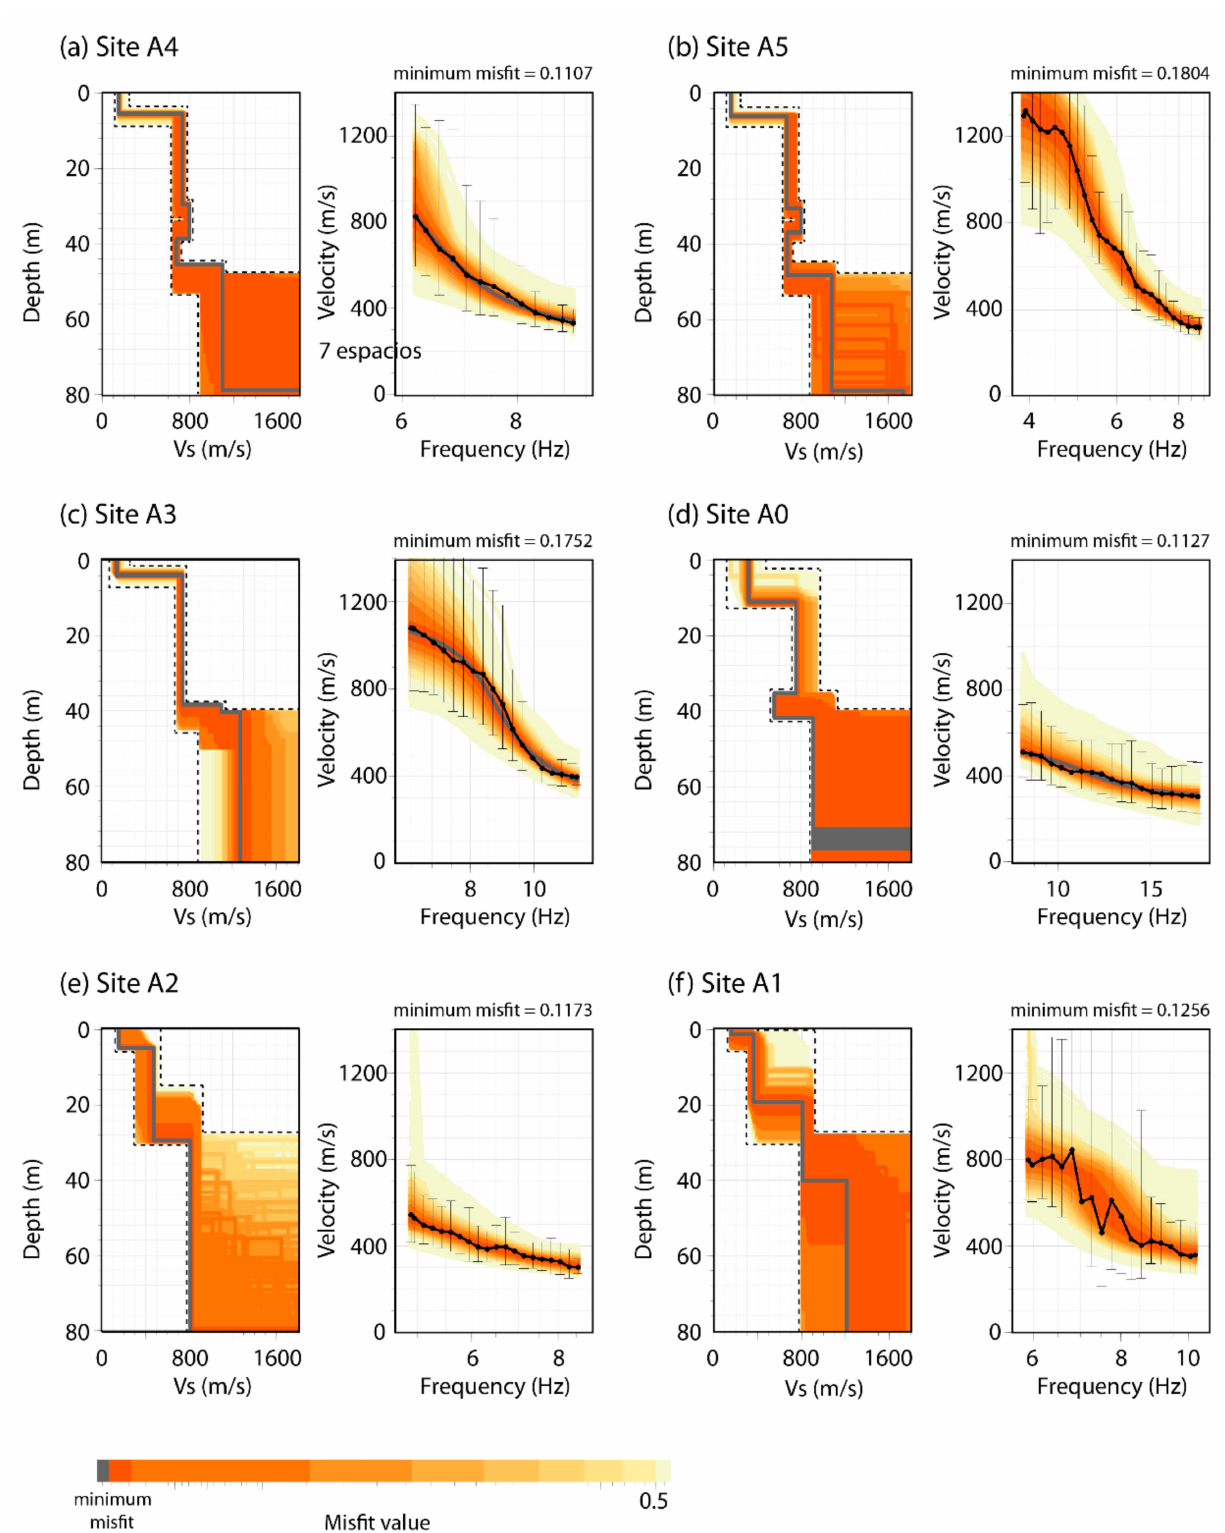
Figure 8. Dispersion curve inversion for six different sites (see Figure 3 for location of sites). The best dispersion and velocity models (dark gray lines), together with models lying inside the minimum misfit + 10% (dark orange) and all the tested models, are shown. The black curve and bars in the velocity-frequency plots are the average and standard deviation, respectively, of the experimental dispersion curve. The dashed lines in the velocity profiles indicate the search